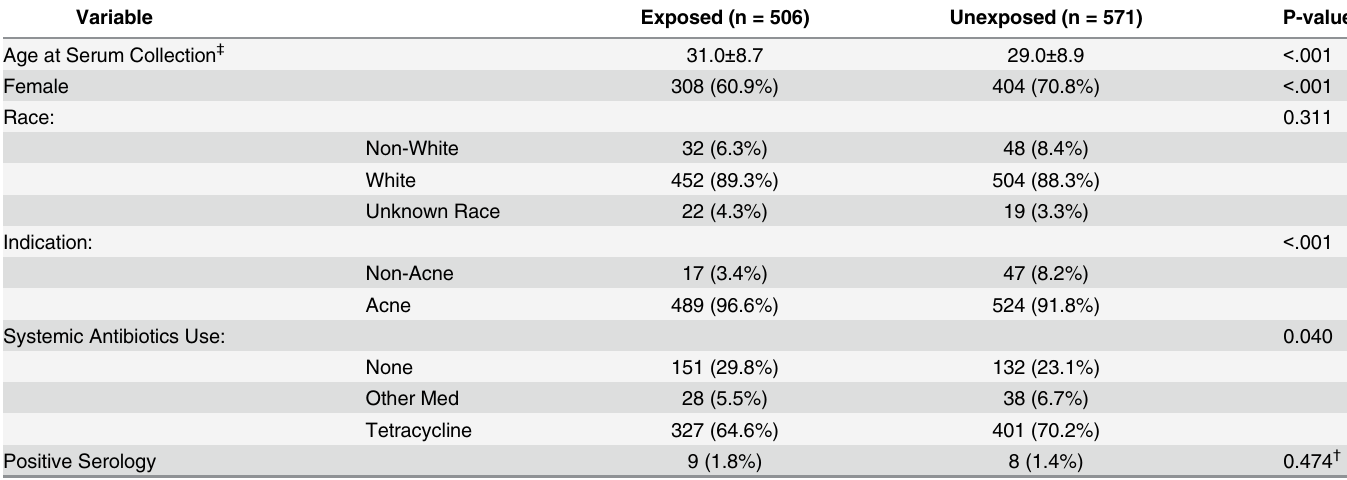
Table 2. Isotretinoin Exposure and Latent